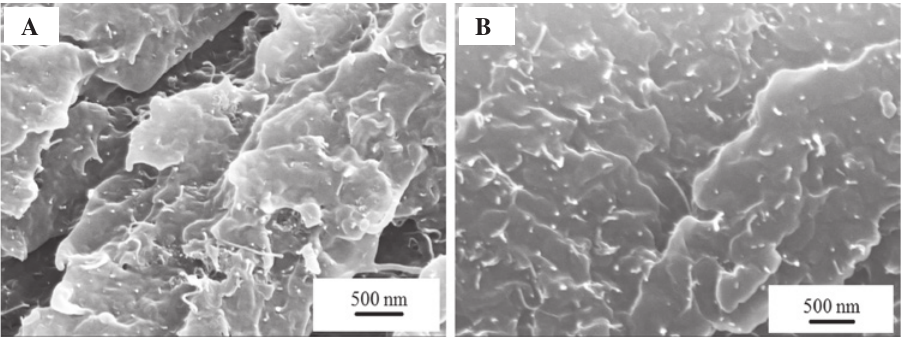
Figure 8: SEM micrographs of the fractured surfaces of the 2.5 wt.% MWCNT/PC composites obtained at the injection temperature of 280 ° C with (A) the injection speed of 10 mm/s and (B) the injection speed of 80